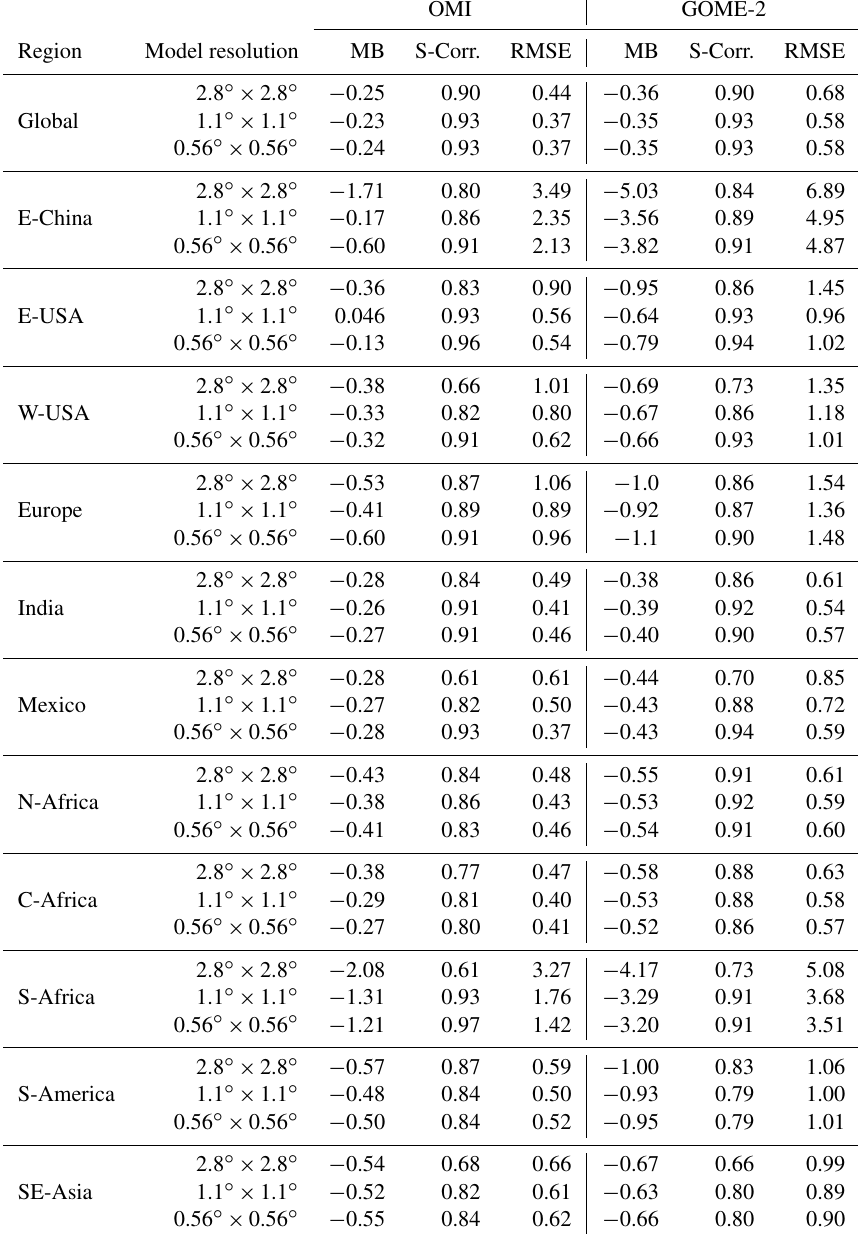
Table 1. Comparisons of annual mean tropospheric NO 2 column between satellite retrievals (OMI and GOME-2) and the model simulation at 2.8, 1.1, and 0.56 ◦ resolutions. MB is the mean bias. RMSE is the root mean square error. S-Corr. signifies the spatial correlation coefficient. Units of MB and RMSE are × 10 15 moleculescm − 2 . The definition of the regions is the same as in Fig.